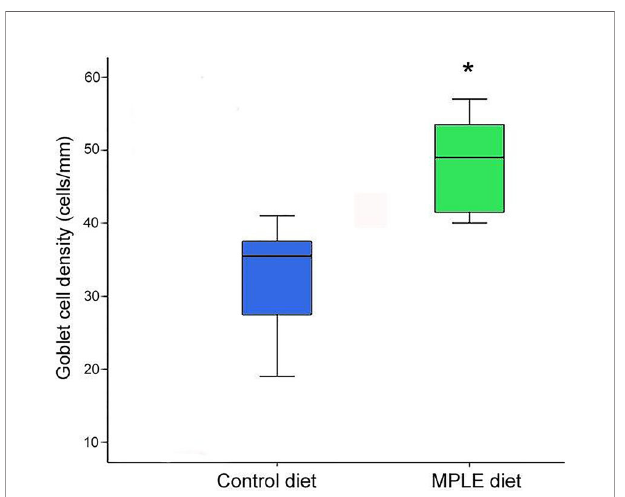
FIGURE 2 | Goblet cell density in the intestine of gilthead seabream ( Sparus aurata ) fed a control or a medicinal plant leaf extract (MPLE)-supplemented diet. The MPLE included in the basal diet was obtained from sage ( Salvia of fi cinalis ) and lemon verbena ( Lippia citriodora ). The asterisk indicates statistically signi fi cant differences among dietary treatments (t-test; P < 0.05).